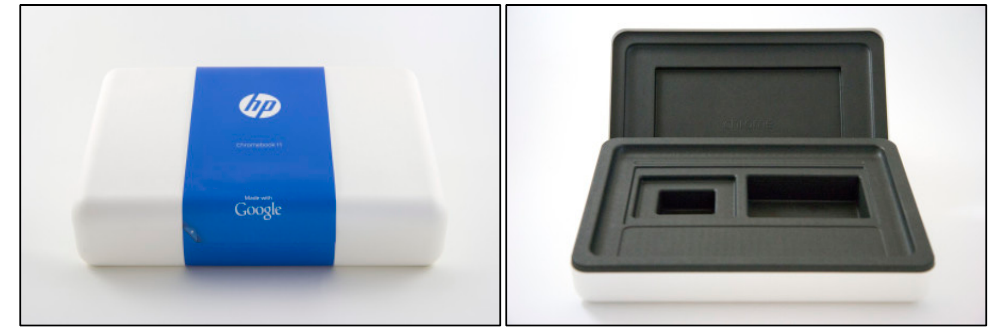
Figure 17. Laptop packaging made from blend of sustainable plant fibres [118].